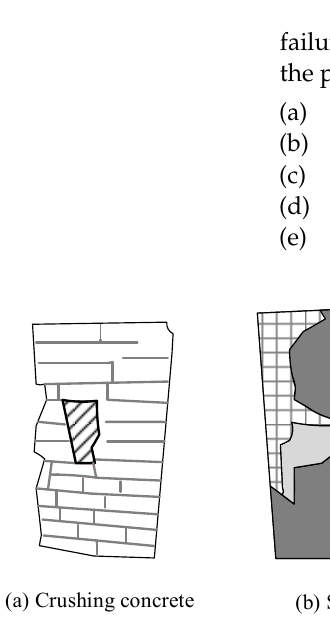
Figure 13. FMs in masonry and TRM-confined columns.